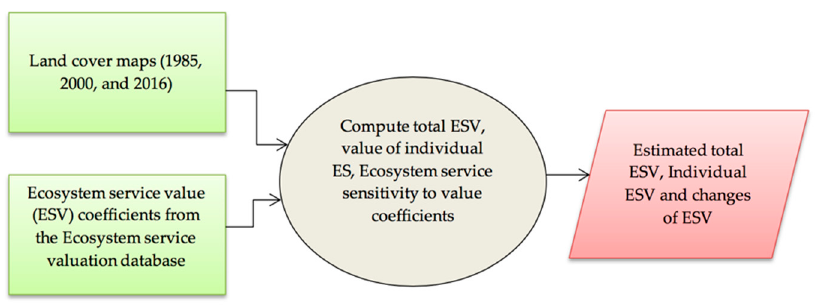
Figure 1. Analytical framework describing the methodological approach of the study. ES: ecosystem services.